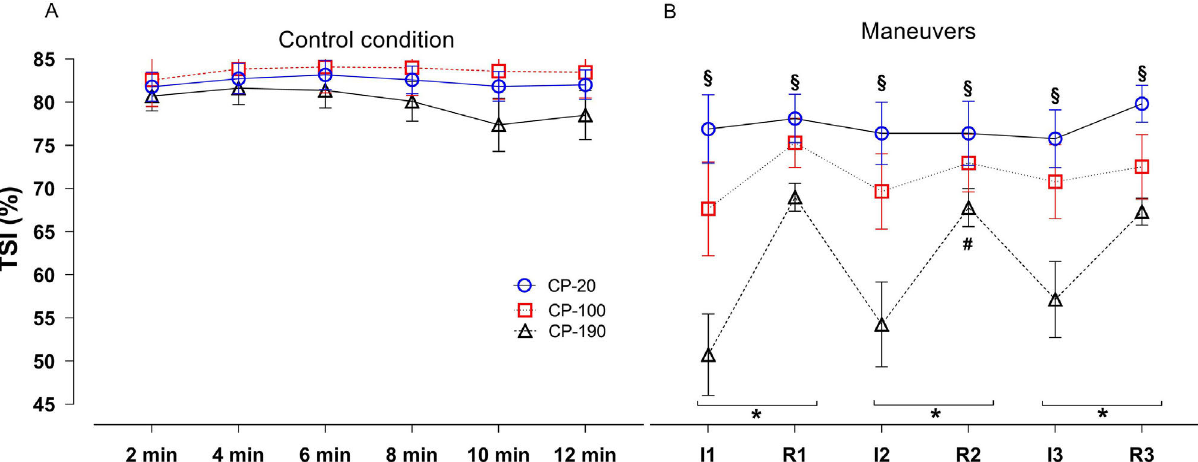
Figure 3 - (A) Graphic of TSI in the control condition (no cuff). (B) Graphic of TSI during the ischemia and reperfusion cycles of the maneuvers and TSI, tissue saturation index; CP-190, cuff-pressures of 190 mmHg; CP-100, cuff-pressures of 100 mmHg; CP-20, cuff-pressures of 20 mmHg; I, Ischemia; R, Reperfusion. Data express in mean ± SD. Difference in comparison between I and R within CP-190 represent by ⋆ . Difference in comparison between CP- 190 and CP-20 represent by § . Difference in comparison between CP-20 and CP-100 represent